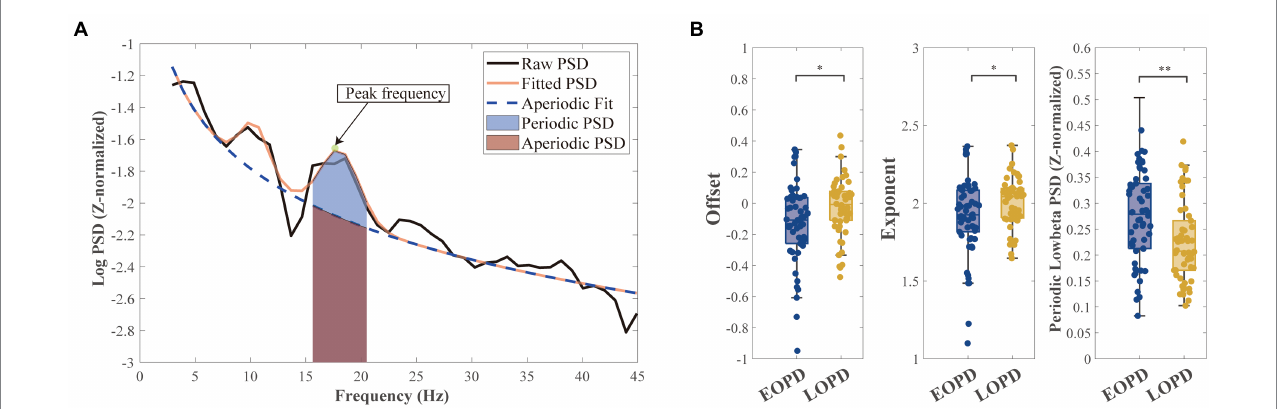
FIGURE 1 Schematic diagram of parameterization of power spectra. (A) An example of parameterizing the power spectra: the aperiodic component (blue dashed line) and the fitted spectra (orange full line). Mixed power is equal to the sum of periodic power (light blue shadow) and aperiodic power (light purple shadow). Peak frequency (green point and arrowed) in low-beta band with highest power was selected for subsequent burst analysis. (B Left) Early-onset Parkinson disease (EOPD) patients demonstrated lower offset than late-onset Parkinson disease (LOPD) patients (EOPD: − 0.14 ± 0.28, LOPD: − 0.02 ± 0.19, p = 0.010), meaning EOPD patients had a lower spectrum curve. (B Middle) EOPD patients demonstrated lower exponent than LOPD patients (EOPD: 1.92 ± 0.25, LOPD: 2.00 ± 0.16, p = 0.047), meaning LOPD patients had a steeper spectrum curve. (B Right) After separating the aperiodic components from the periodic